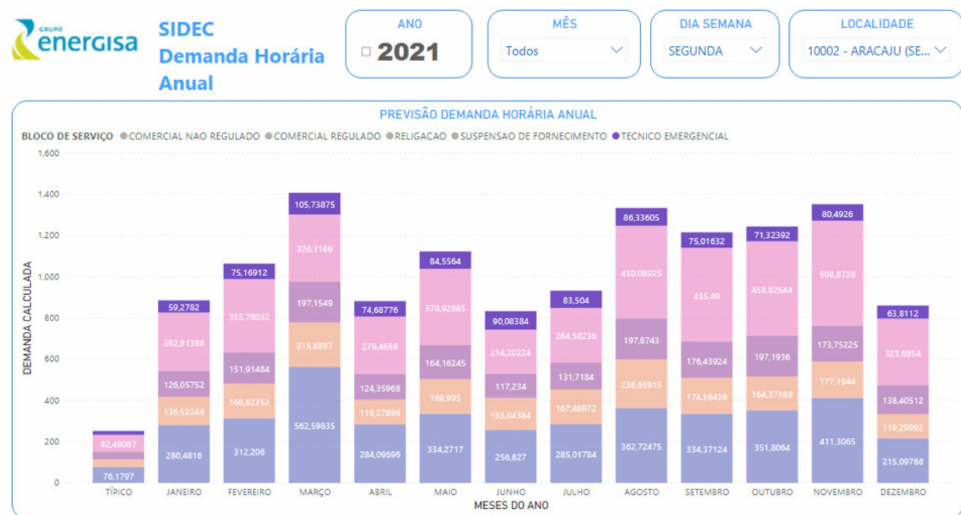
Figure 5. Monthly distribution of the hourly forecasted service orders throughout the year for a Monday in Aracaju city, Sergipe state, Brazil. This figure is one of the graphical interfaces of AWDEC, developed in Microsoft Power BI. The terms in Portuguese represents year (ano), month (m ê s), day of the week (dia semana), location (localidade), service type (bloco de serviço), commercial without deadline (comercial n ã o programado), commercial with deadline (comercial programado), reconnection (religaç ã o), power cut (suspens ã o de fornecimento) and emergency (t é cnico emergencial). The months are January (Janeiro), February (Fevereiro), until December (Dezembro).